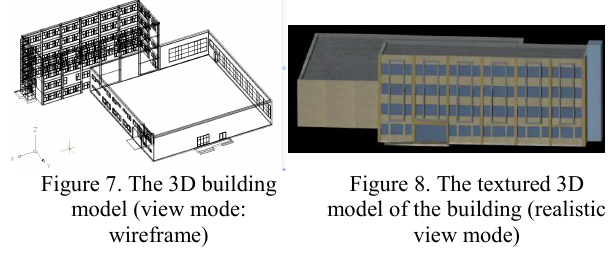
Figure 10. Rectified image of the north facade (from Cannon